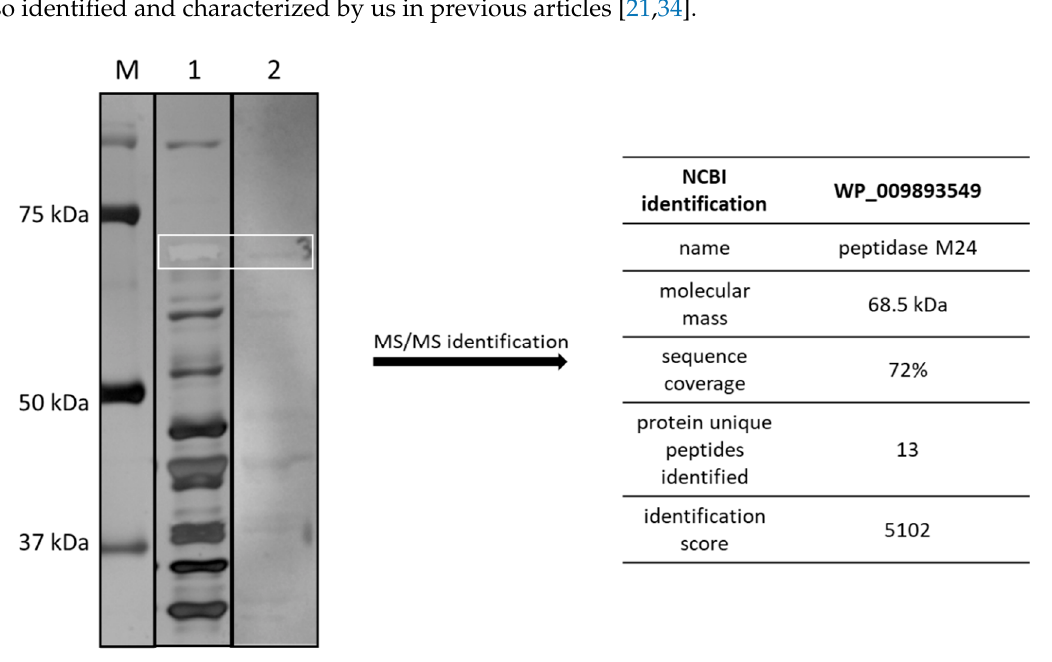
Figure 1. Identification of M24 as a one of the immunoreactive proteins of CD. Surface protein isolate was separated using SDS-PAGE electrophoresis (12.5% gel). One gel was stained with silver method (lane 1). The duplicate gel was subjected to Western blotting using umbilical cord blood serum as primary antibodies and anti-human IgG as secondary antibodies (lane 2). Immunoreactive band (white box) was excised from the gel and identified by MS/MS analysis. M-marker lane. NCBI = Na- tional Center for Biotechnology Information.